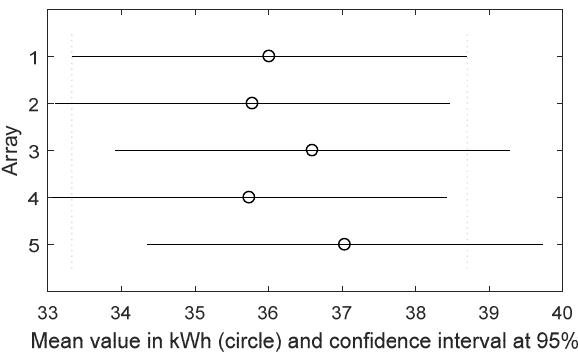
Figure 8. Box plot of K-W test of the five distributions for the six-months analysis (January–June).